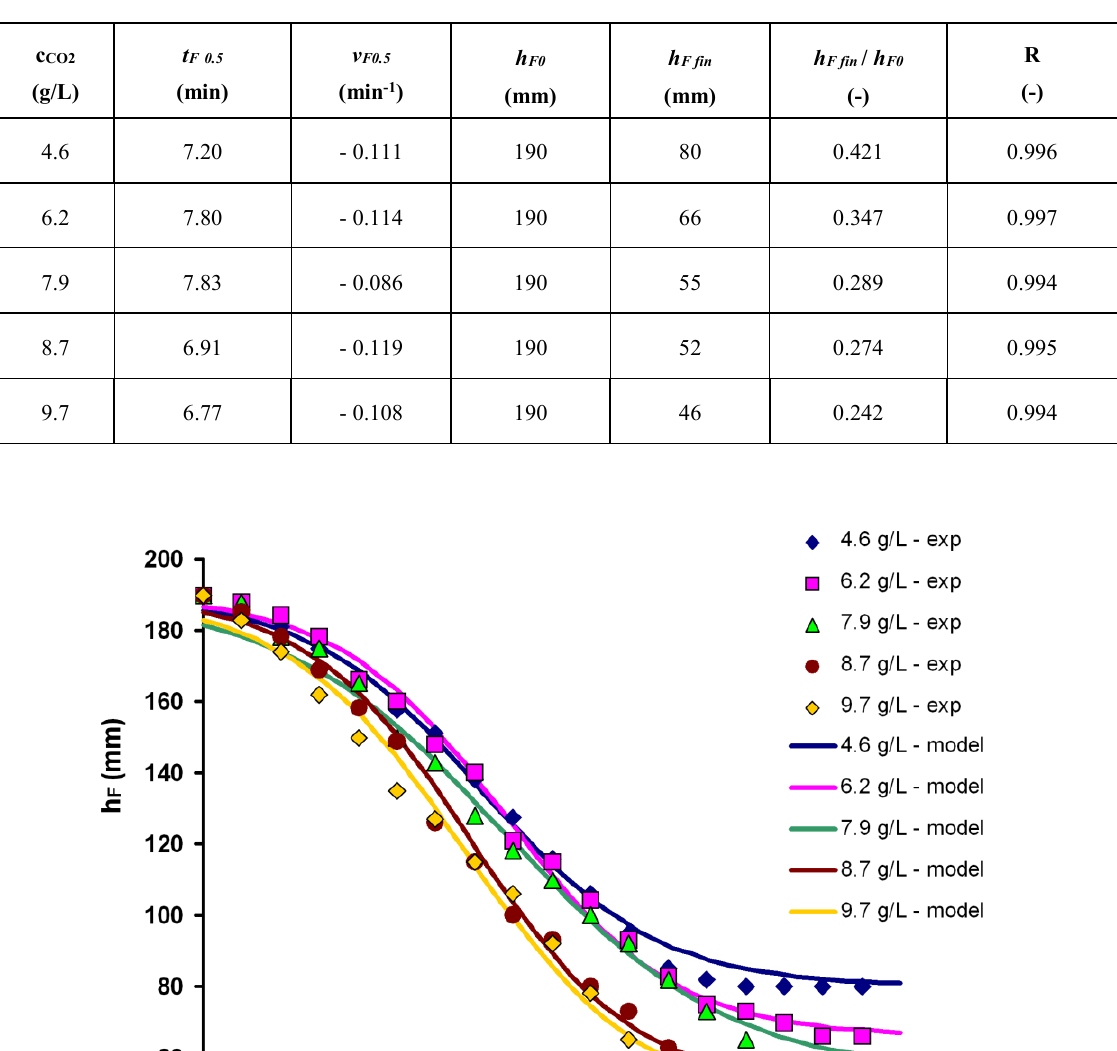
Table 3. Foam decay - effect of beer CO 2 content: S-curve parameters.